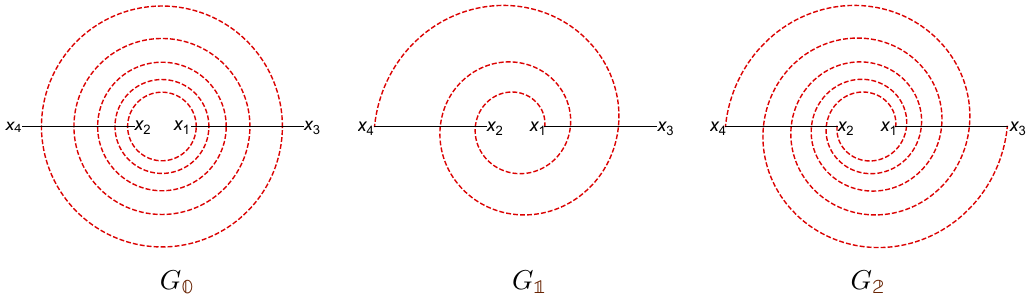
Figure 5 . Three basic types of the skeleton graphs corresponding to zero, one and two magnons. They have the structure of wheels, single and double spirals. These basics graphs are the building block of all correlators we discuss in this paper. Another way to represent the same graphs given on (cid:12)gure